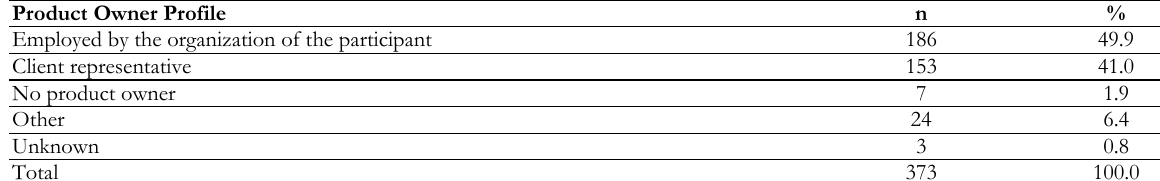
Table 3. Product Owner Profile in the Agile Team